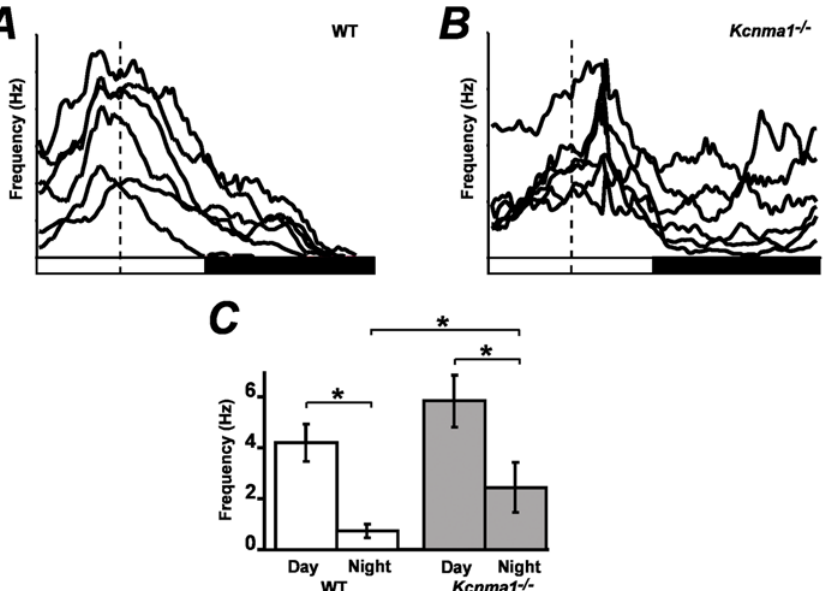
Figure 2. SFR rhythms from WT and Kcnma1 2 / 2 SCNs. A and B, MEA recordings from 6 channels on cycle 2 within a WT ( A ) and a Kcnma1 2 / 2 ( B ) SCN over 24 hr. Data were smoothed by applying a 1-hr moving window average and plotted to maximize any day-night differences in firing rate. Dotted lines denote CT6 (6 hours after lights on for the animal prior to slice harvest), the daytime peak for SFR. C, Individual firing frequencies from cycle 2. The daytime peak (CT5-7) and trough (CT12–14) SFR values were from 5 WT ( n =32 channels) and 4 Kcnma1 2 / 2 ( n =30 channels) slices 6 s.e.m. * p , 0.05.